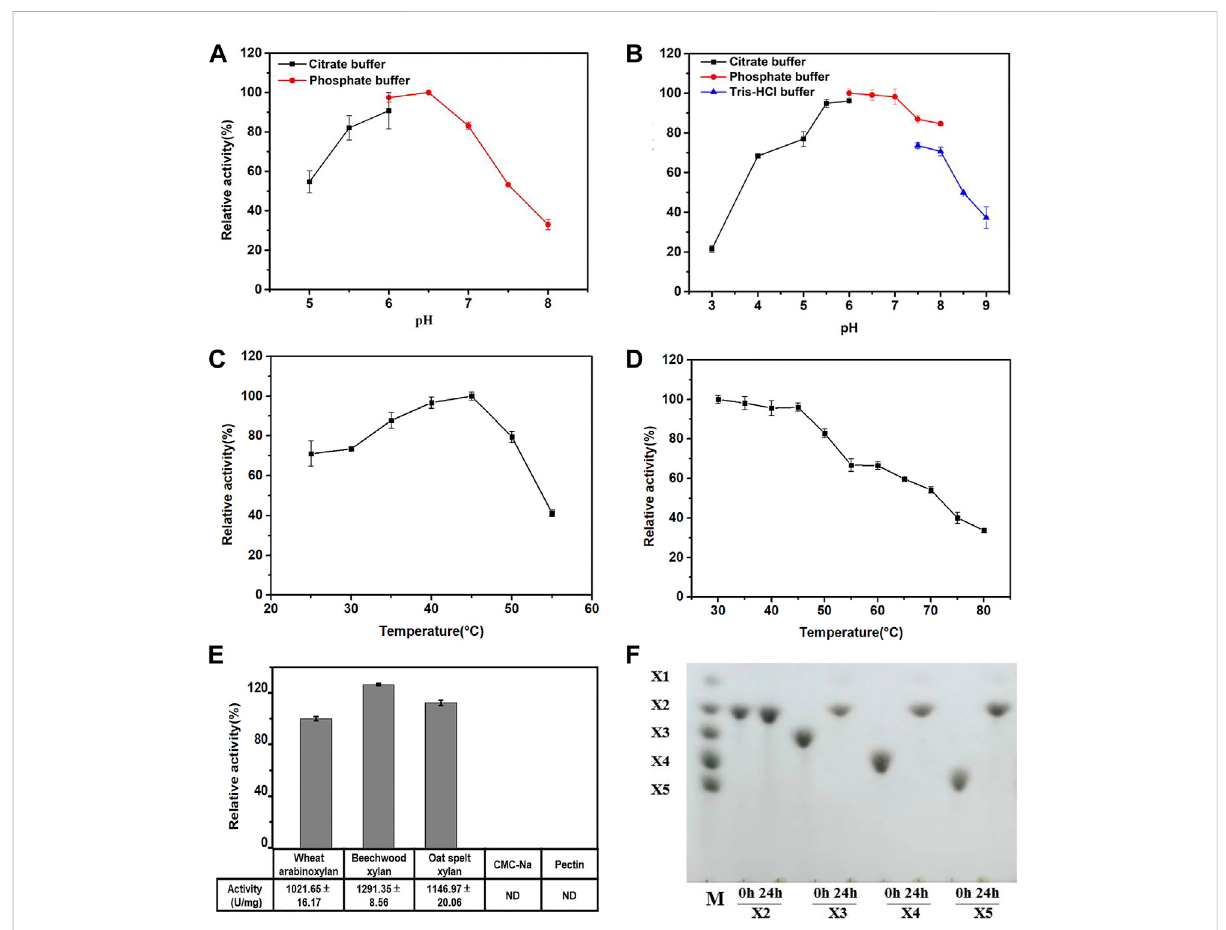
FIGURE 3 Biochemical characteristics of recombinant Hmxyn. (A) Effect of pH on Hmxyn activity. (B) Effect of pH on the stability of Hmxyn. Puri fi ed Hmxyn was incubated at 4 ° C for 12 h in 100 mmol/L citrate buffers (pH 3.0 – 6.0), 100 mmol/L phosphate buffer (pH 6.0 – 8.0) and 100 mmol/L Tris- HCl buffer (pH 7.0 – 9.0). (C) Effect of temperature on Hmxyn activity. (D) Effect of temperature on the stability of Hmxyn. The Hmxyn was incubated in 100 mmol/L phosphate buffer (pH 7.0) at different temperatures (25 – 55 ° C) for 60 min. (E) Substrate speci fi city of Hmxyn. (F)